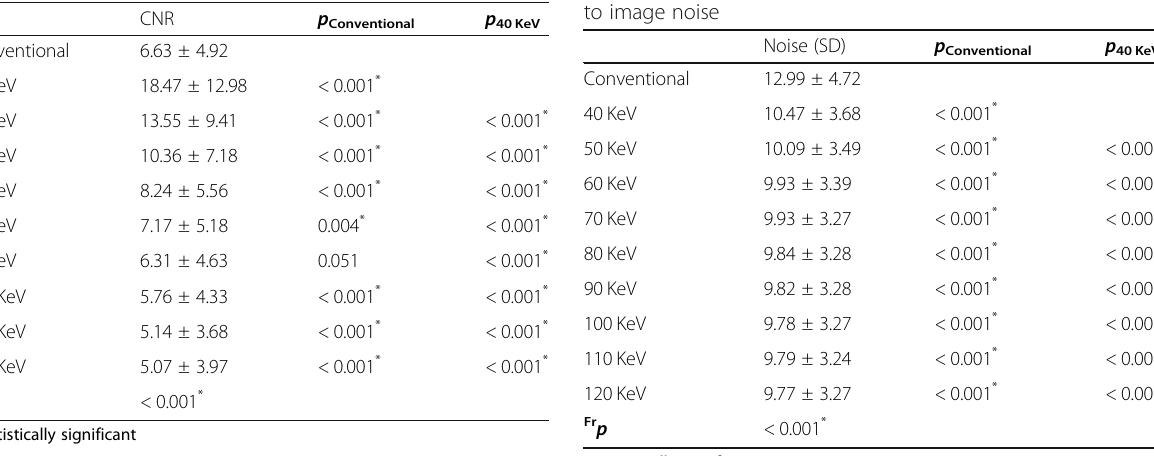
Table 1 Quantitative analysis of image sets (conventional images and VME images 40 – 120 KeV) according to CNR